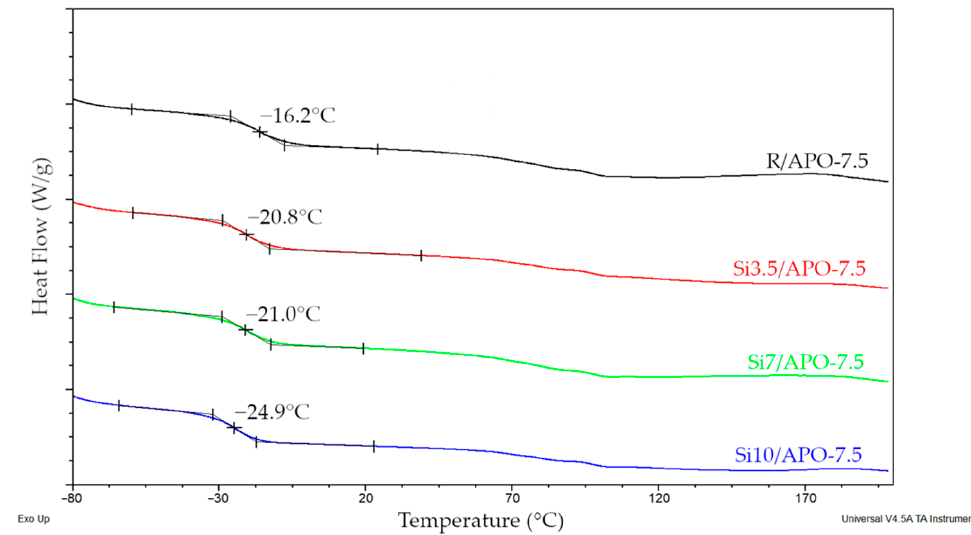
Figure 8. DSC thermograms of the selected PSAs crosslinked under UV radiation with a dose